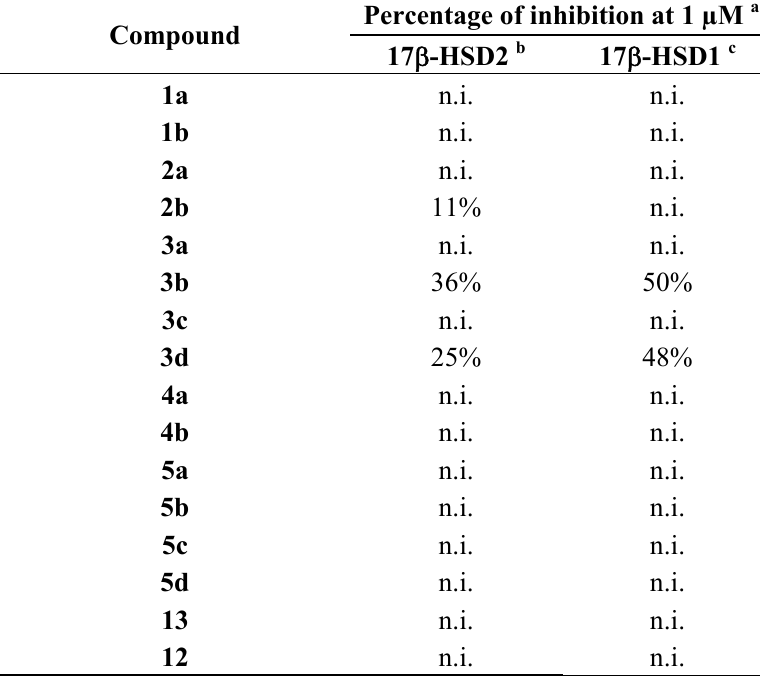
Table 2. In vitro inhibitory potencies toward 17  -HSD2 and 17  -HSD1 of compounds 1a – b , 2a – b , 3a – d , 4a – b and 5a – d , 12 and 13